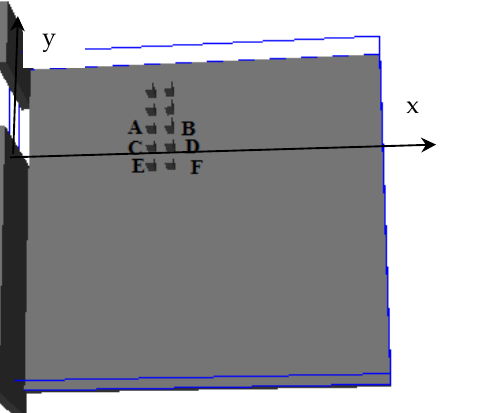
Figure 3. Group of buildings in flooded area.